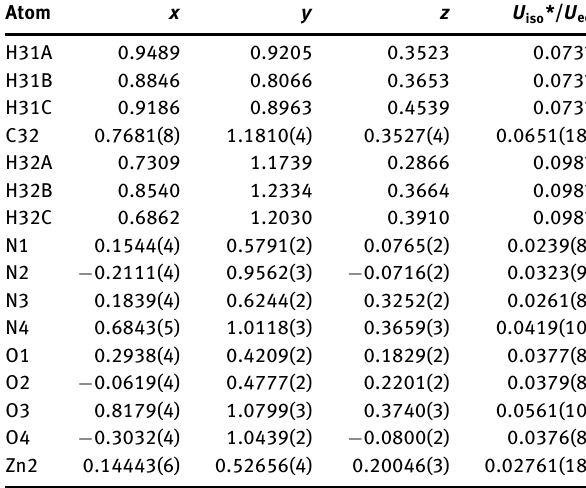
Table 2: Fractional atomic coordinates and isotropic or equivalent isotropic displacement parameters (Å 2